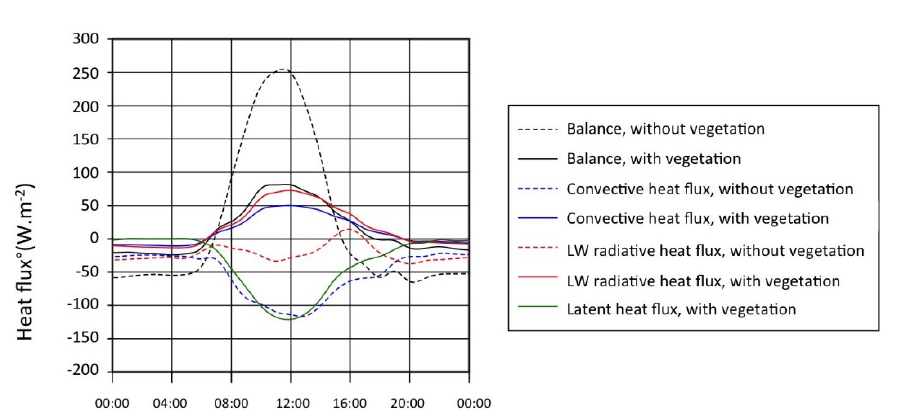
Figure 12. Heat fluxes on external surfaces of the south facing wall, third floor, 26 June 2010.